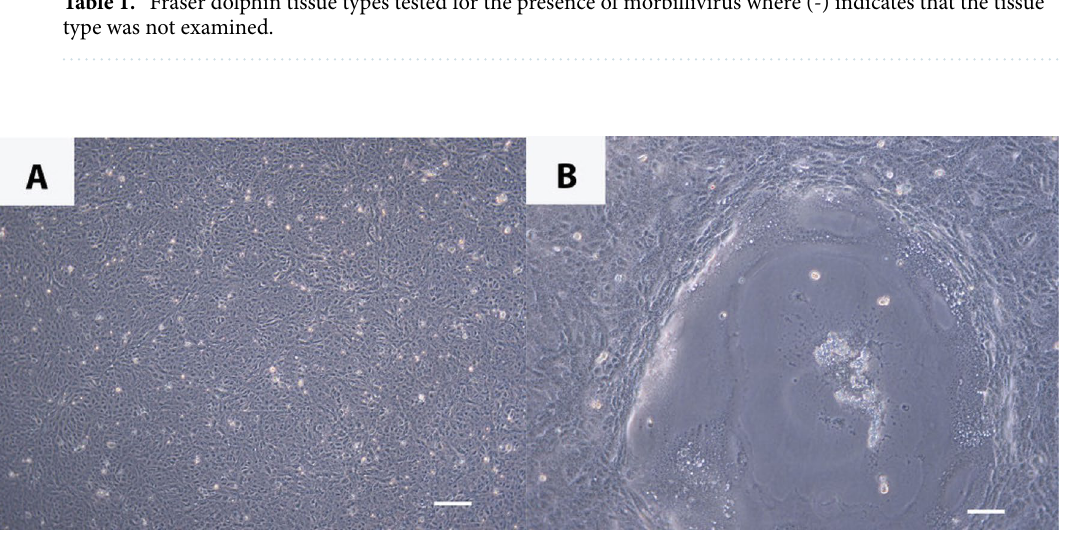
Figure 3. ( A ) Vero.DogSLAMtag control cells. Bar = 200 µm; ( B ) Vero.DogSLAMtag infected with Fraser’s dolphin cerebellum 8 days post infection showing large syncytium. Bar = 200